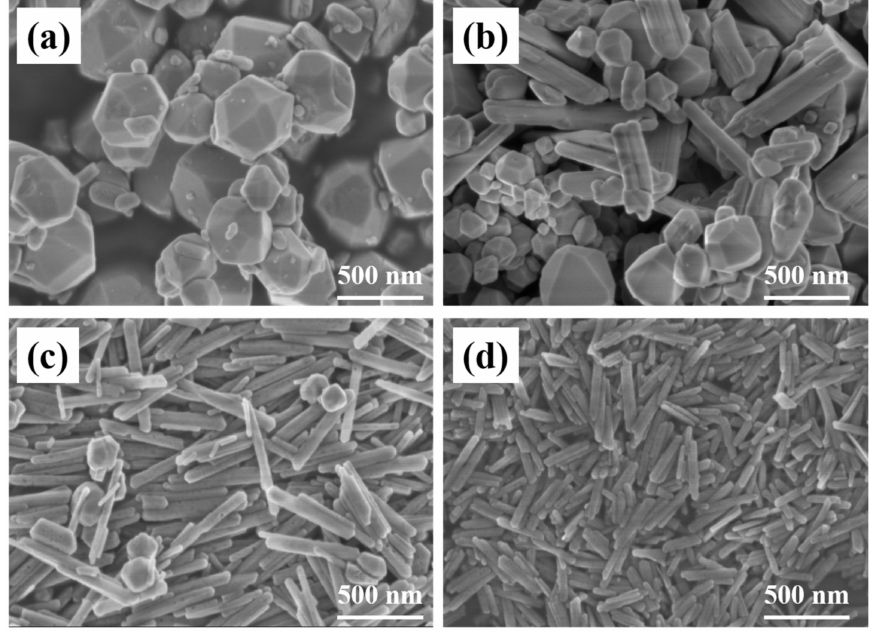
Figure 1. SEM images of Fe 2 O 3 prepared at ( a ) 220 ◦ C; ( b ) 205 ◦ C; ( c ) 190 ◦ C; ( d ) 175 ◦ C. Figure 2 is the SEM diagrams of rGO/Fe 2 O 3 -175 ◦ C with different ratios of graphene, the nanorod morphology of Fe 2 O 3 in rGo/Fe 2 O 3 -175 ◦ C does not change